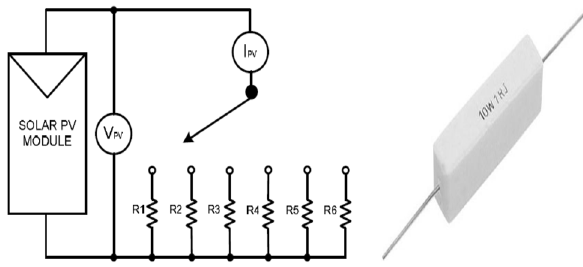
Figure 4. The varying resistance load and the 10 W power